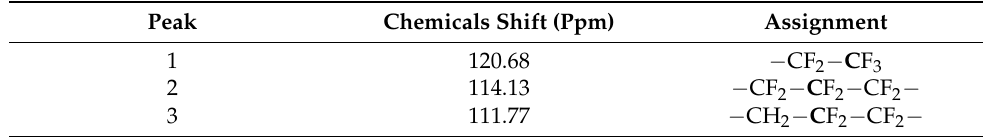
Figure 12. Sequence of repetitive units in Fluo AQ.